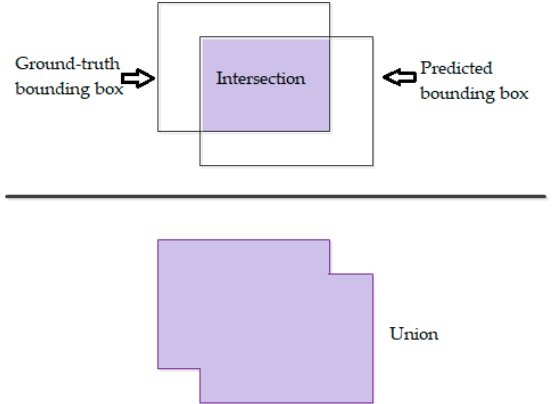
Figure 6. The implication of IoU.